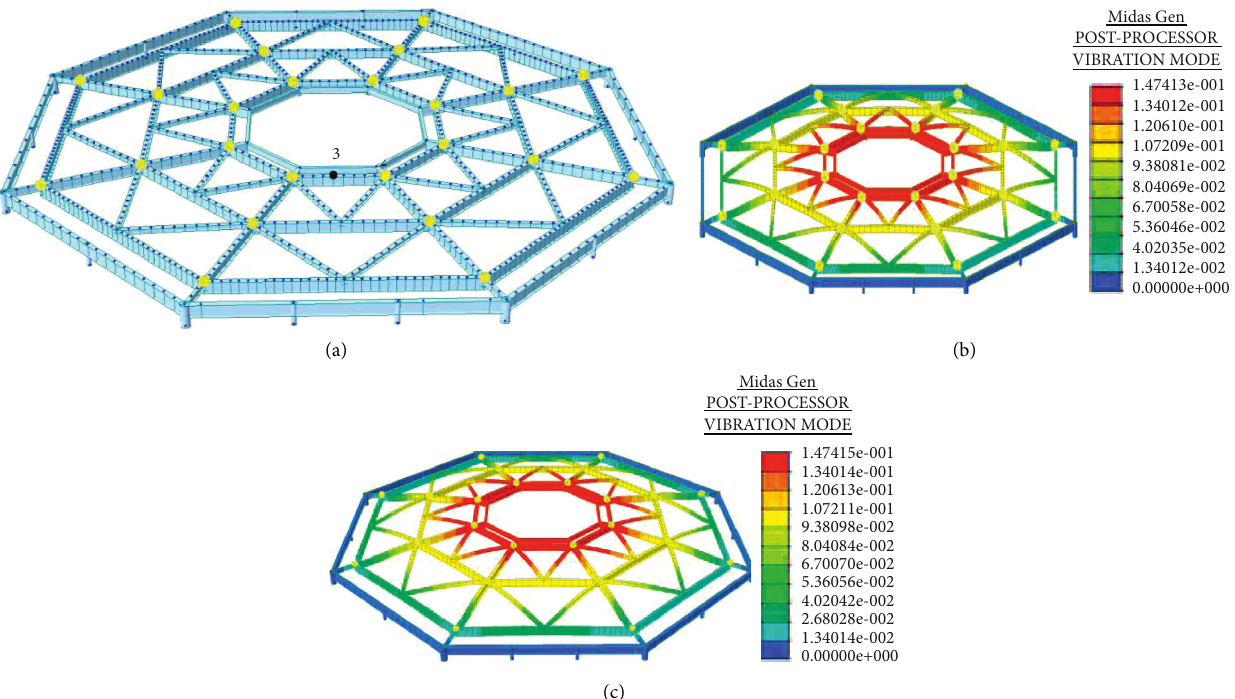
Figure 13: Simulated first vertical mode shape of the equivalent local FE model. (a) The equivalent local FE model of structure. (b) Equivalent local model A . (c) Equivalent local model B .